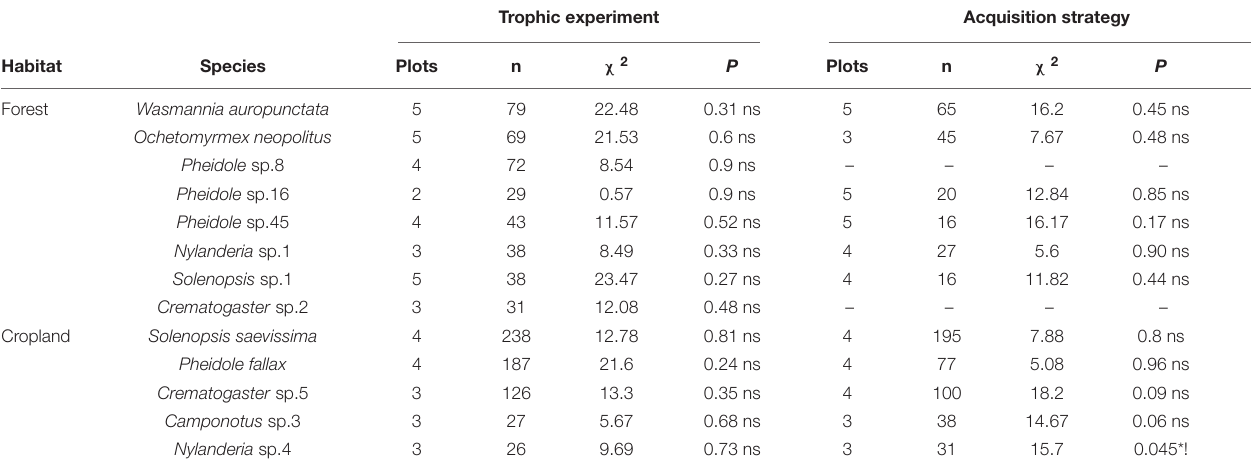
Trophic experiment Acquisition strategy